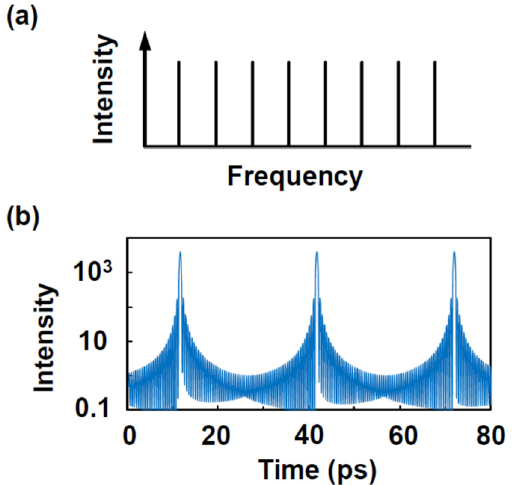
Figure 1. Mode-locked ( a ) frequency comb and ( b ) pulse train.